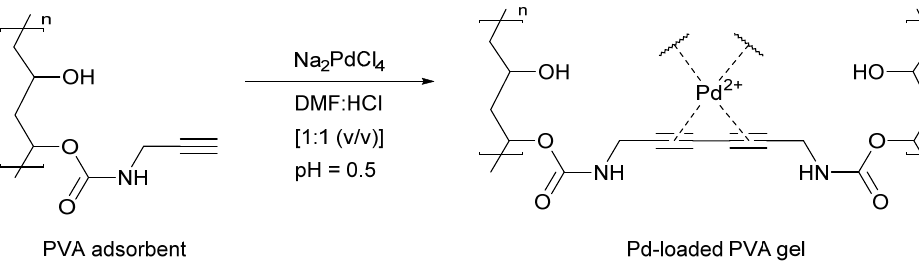
Figure 10. Palladium recovery enabled by a Glaser coupling to yield a cross-linked gel, Reproduced with permission from [99].